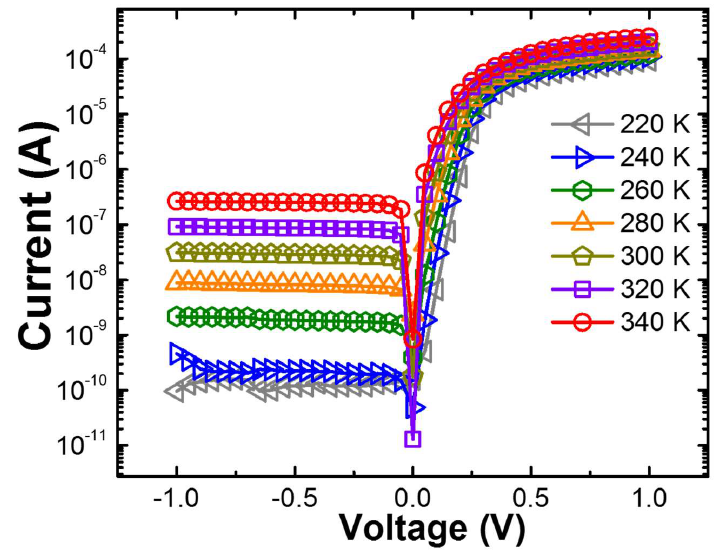
Figure 2. Temperature-dependent I – V characteristics of Au/a-plane GaN templates grown via GaN nanodot formation.